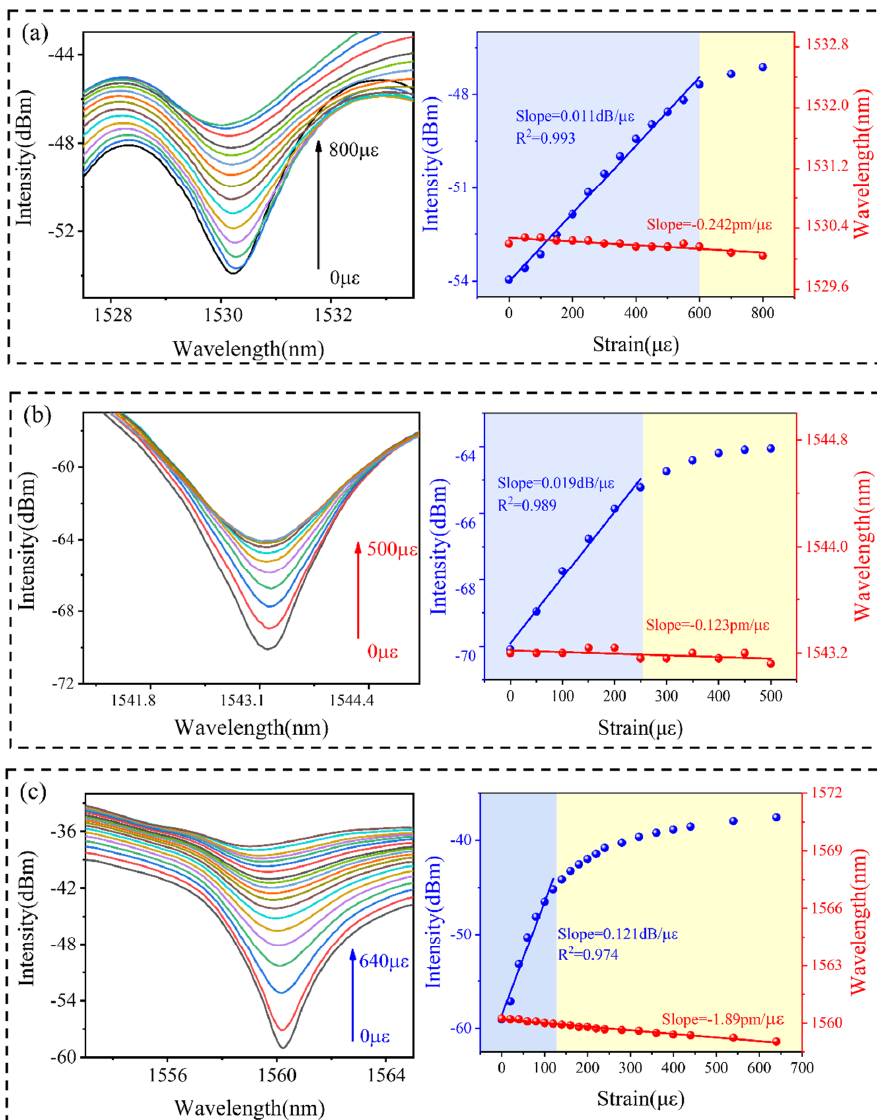
Figure 5. The transmission spectra of axial strain responses with different length of TCF. ( a ) L TCF = 50 mm, ( b ) L TCF = 30 mm and ( c ) L TCF = 15